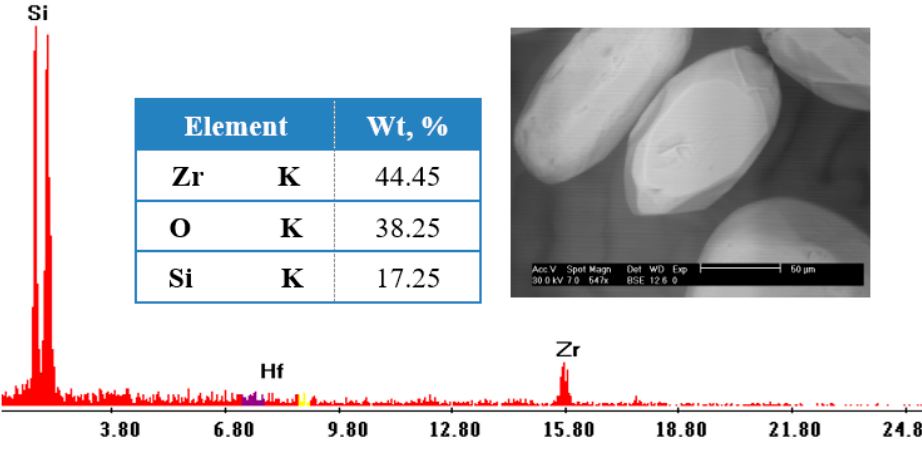
Figure 13. SEM-EDX of the Egyptian Zircon concentrate.